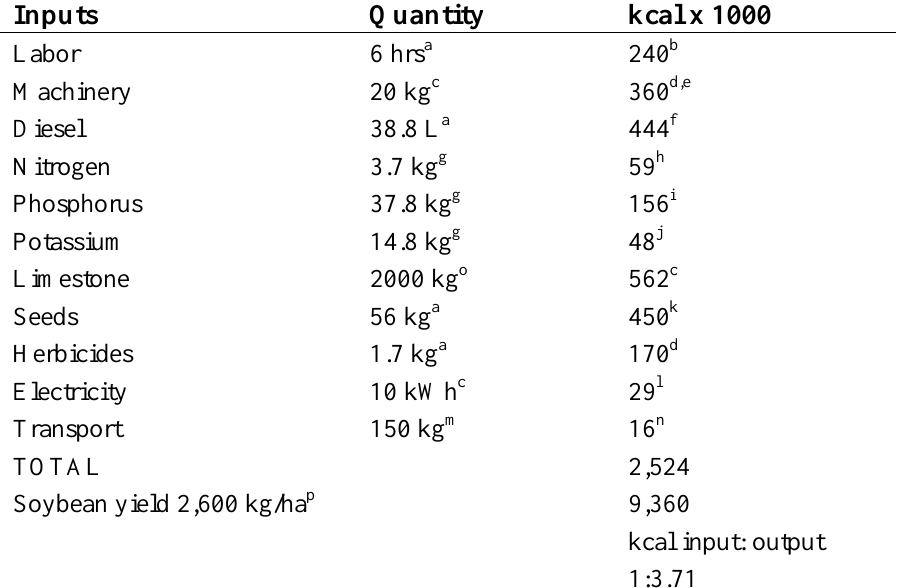
Table 10. Energy inputs in soybean production per hectare in the